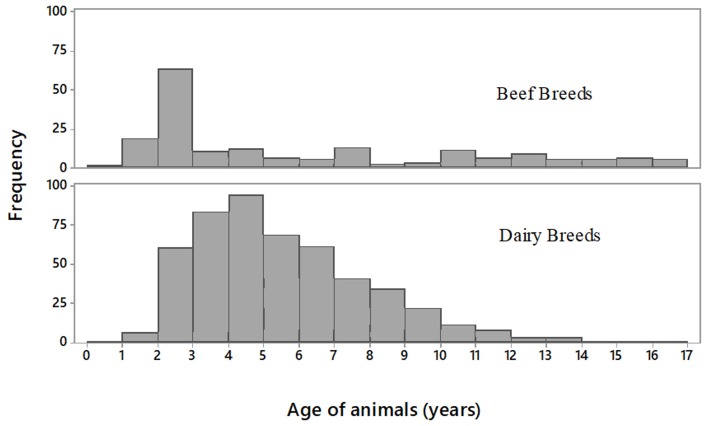
Histograms showing the age distribution of the sample population (n = 680 in total) grouped by beef breeds (n = 181) and dairy breeds (n = 499).